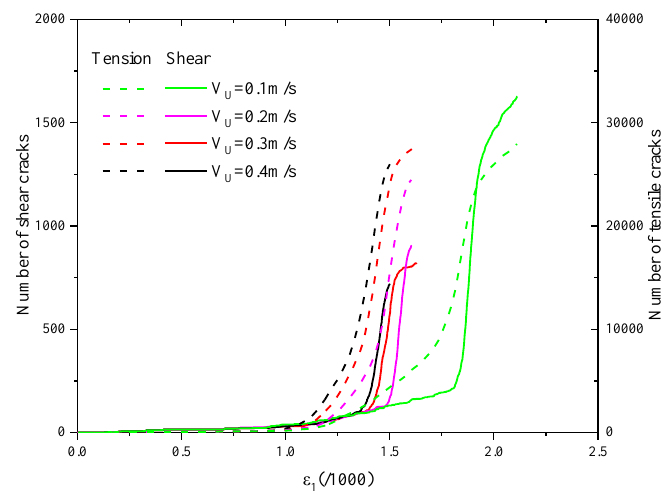
Figure 19. Influence of unloading rates of confining pressures on number of microscopic cracks.